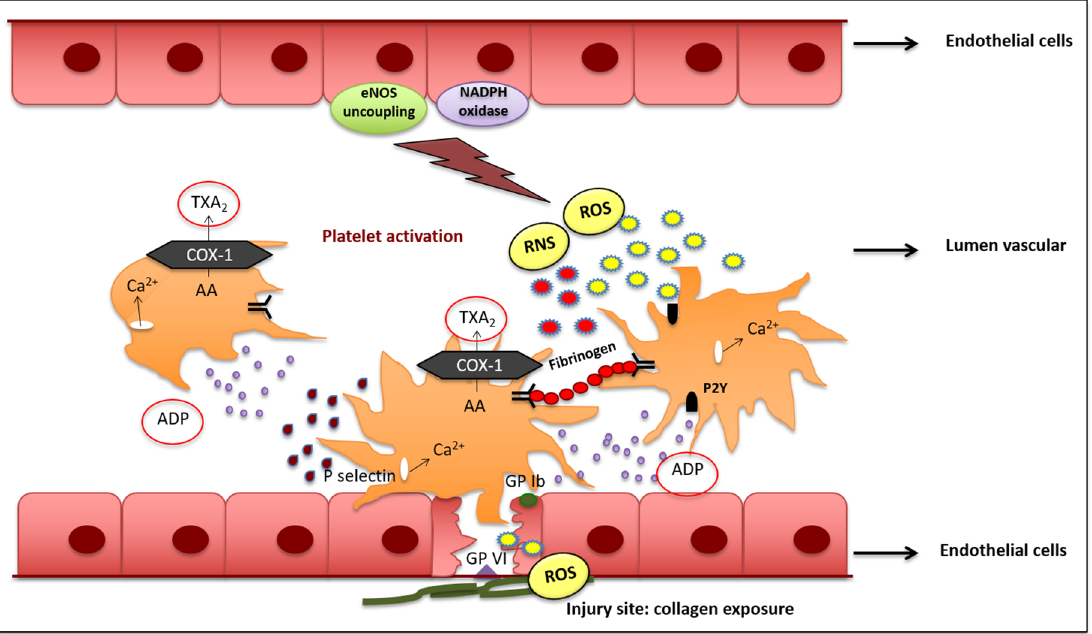
Figure 1. Platelet activation following exposure to collagen at the injury site and the production of free radicals. Protein tyrosine-phosphatases (PTPs) are the primary targets of ROS which, in turn, drive the upregulation of GPVI signaling. This event results in the overstimulation of platelets, inducing cytosolic calcium mobilization and the release of proaggregating factors from granules. Due to endothelial dysfunction, uncoupled eNOS uncoupling and NOX activation lead to the overproduction of ROS and RNS which are able to interact with platelets through the ADP receptor, triggering the same intracellular signaling pathway. Furthermore, nitrogen peroxide triggers the activation of fibrinogen and the stabilization of the fibrin clot. Thus, endothelial dysfunction and platelet activation in primary hemostasis, both consequences of a pro-oxidant state, converge and amplify each other, causing important prothrombotic effects. AA: Arachidonic Acid; COX-1: